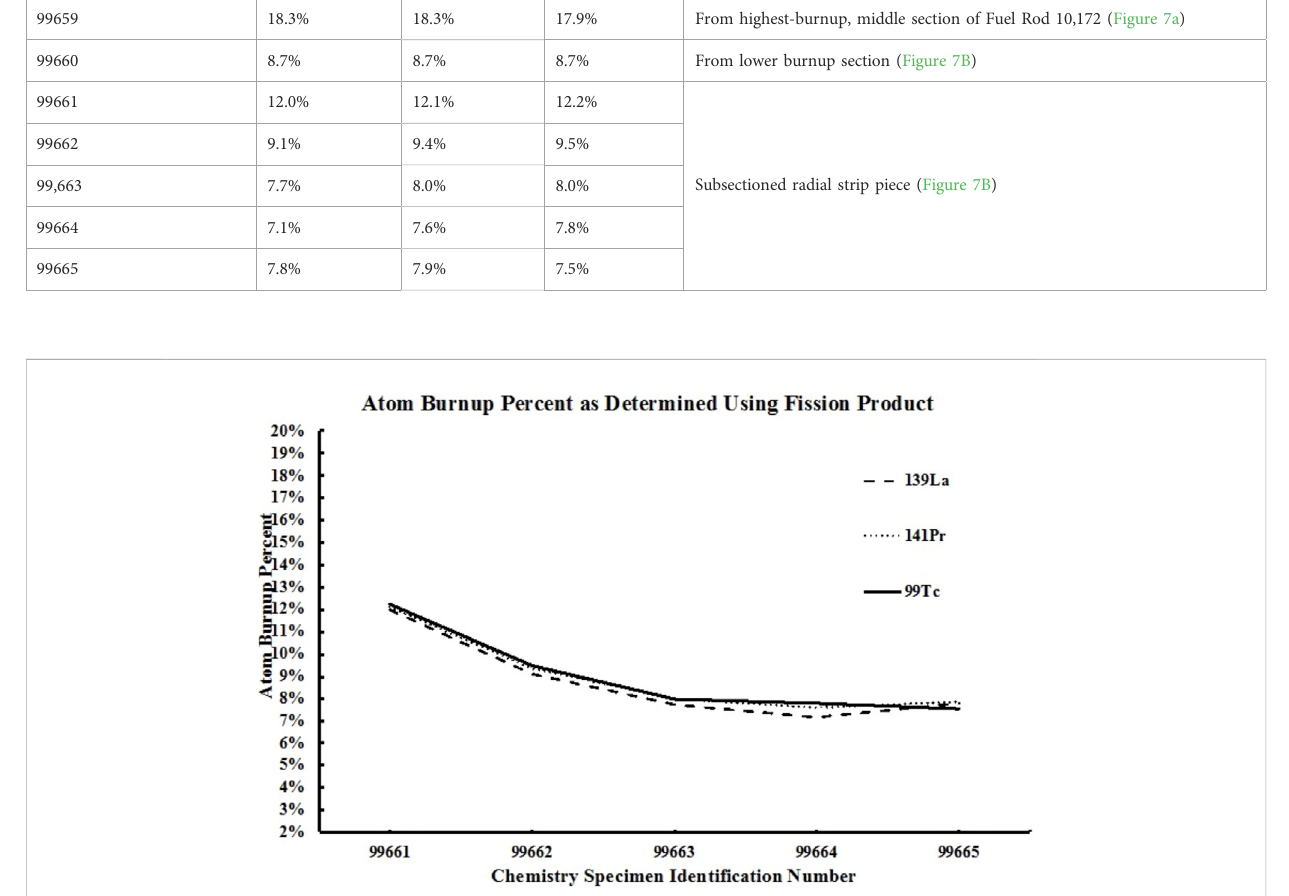
Plotted burnup values calculated via fi ssion product measured using chemistry and